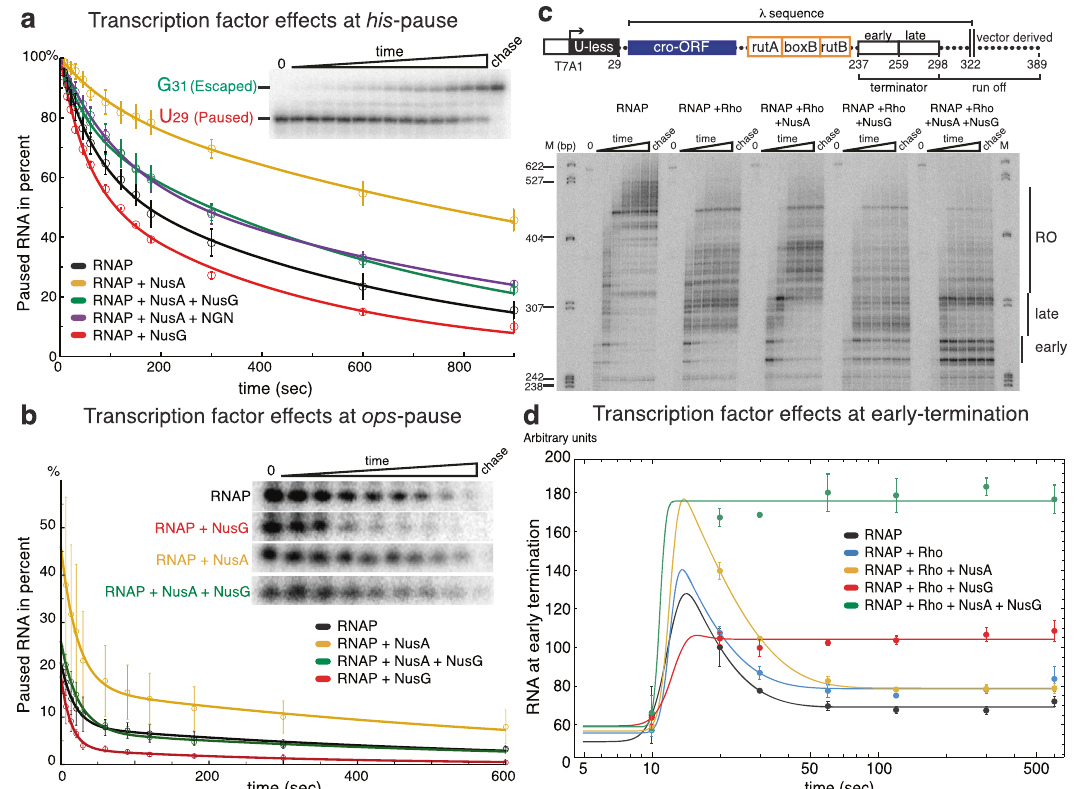
Fig. 4 Transcription elongation and termination kinetics regulated by NusA and NusG. For all panels, RNA was quanti fi ed in triplicates ( n = 3) and error bars indicate standard deviations from the mean (the source data are provided as a Source Data fi le). a RNAP transcription elongation complexes were assembled upstream of the E. coli his -pause to measure pause escape rates. Pause escape rates quanti fi ed from denaturing gel electrophoretic assays (representative result shown in inset). NusA decreased pause escape rates 2-fold (yellow). NusG slightly increased escape rates (red). When both factors were present (or NusA and NGN), rates were almost reaching the level of RNAP alone (green, purple and black). b Transcriptional pausing at the ops -pause measured in single-round transcription assays and analysed by denaturing gel electrophoresis (inset). NusG (red) increased rates of escape from the pause, while NusA (yellow) increased the fraction of paused RNAP and slowed down escape rates. When both factors were present, they cancelled each other ’ s effect (black and green). c Schematic of the assay template DNA (top), and a representative gel of the Rho-dependent termination assay in the presence or absence of TFs (bottom). The template DNA contained a T7A1 promoter, a U-less region ending with A29, the phage λ cro gene and λ tR1 terminator with the binding site for Rho (rutA, boxB and rutB). Transcription terminated in the early or the late region (early: 237-259, late: 259-298). 298- 322 represents the sequence downstream of the λ cro-tR1, and 322-389 is derived from the vector. The terminator and the run off region are indicated. Terminated and run-off transcription products were measured over time in single-round transcription assays. In the absence of TFs, most RNA products by-passed terminators and transcription ended in the run-off region. Rho caused termination in the late region. NusA increased pausing in the terminator regions but RNAP eventually extended those transcripts. Termination occurred ef fi ciently in presence of NusG and even more so in the early region when both NusG and NusA were present. d Quanti fi cation of the early termination ef fi ciency in presence of the indicated set of transcription factors over time. Plotted curves were obtained by mathematical modelling (see Methods section for details), y axis represents arbitrary